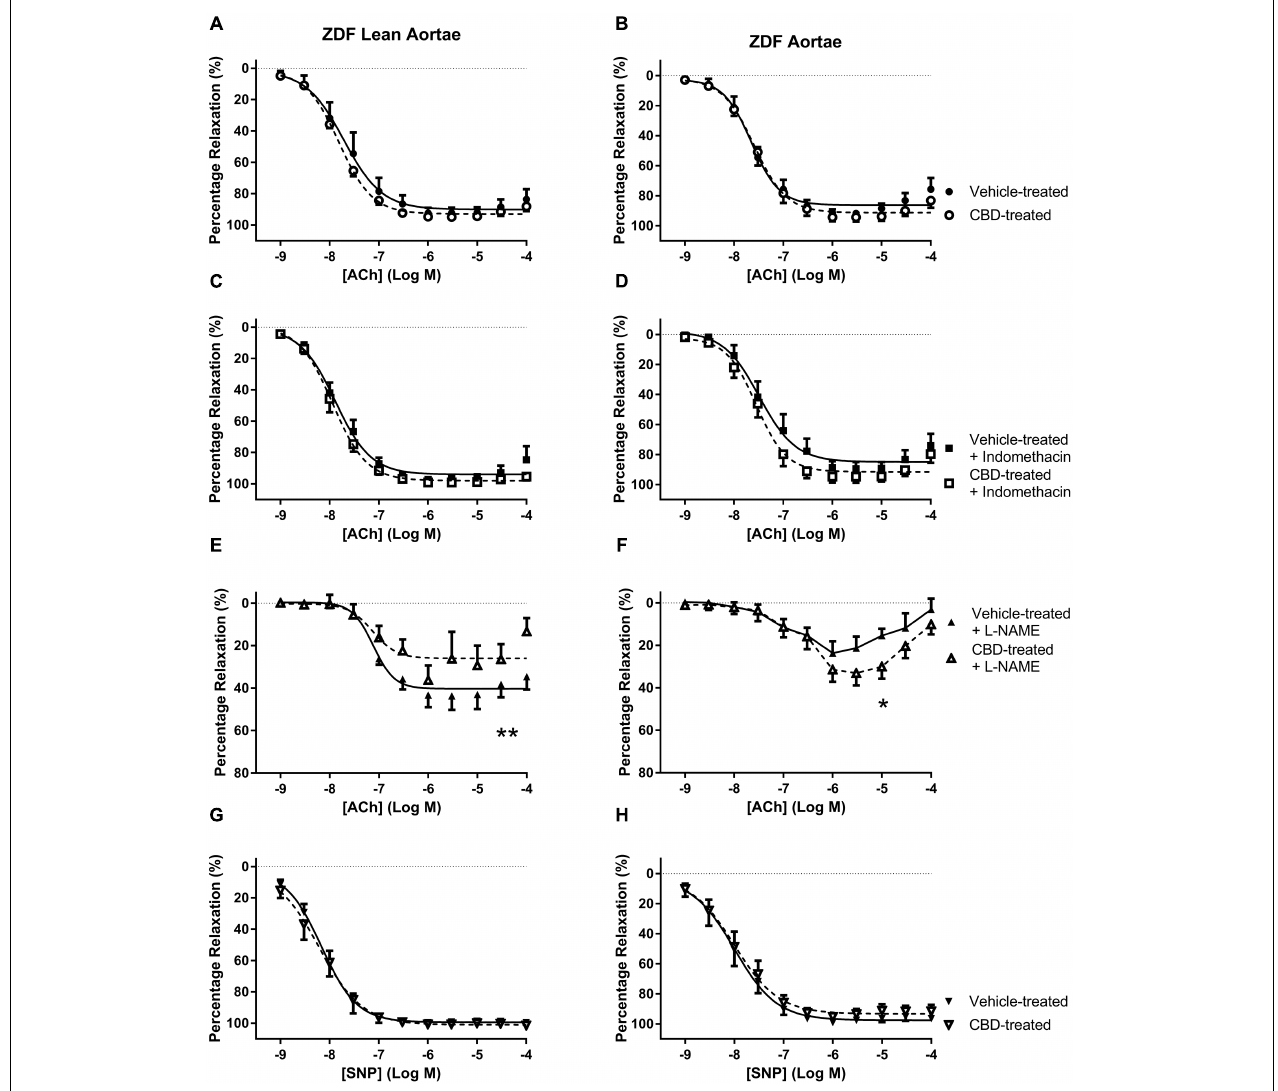
FIGURE 4 | The effect of CBD (open symbols) or vehicle (closed symbols) treatment on ex vivo responses to ACh (A–F) and SNP (G,H) in aortic rings taken from ZDF Lean (left side) or ZDF rats (right side). Some arteries were incubated in vitro in the presence of 3 µ M indomethacin (squares, C,D ), or 300 µ M L-NAME (upward triangles, E,F ). Data are mean ± SEM, n = 5/6. ∗ P < 0.05 by t -test of percentage vasorelaxation at 10 µ M Ach comparing responses to Ach in ZDF arteries after 7 days treatment with CBD, ∗∗ P < 0.01 by t -test between R max values comparing responses to Ach in ZDF arteries after 7 days treatment with CBD.